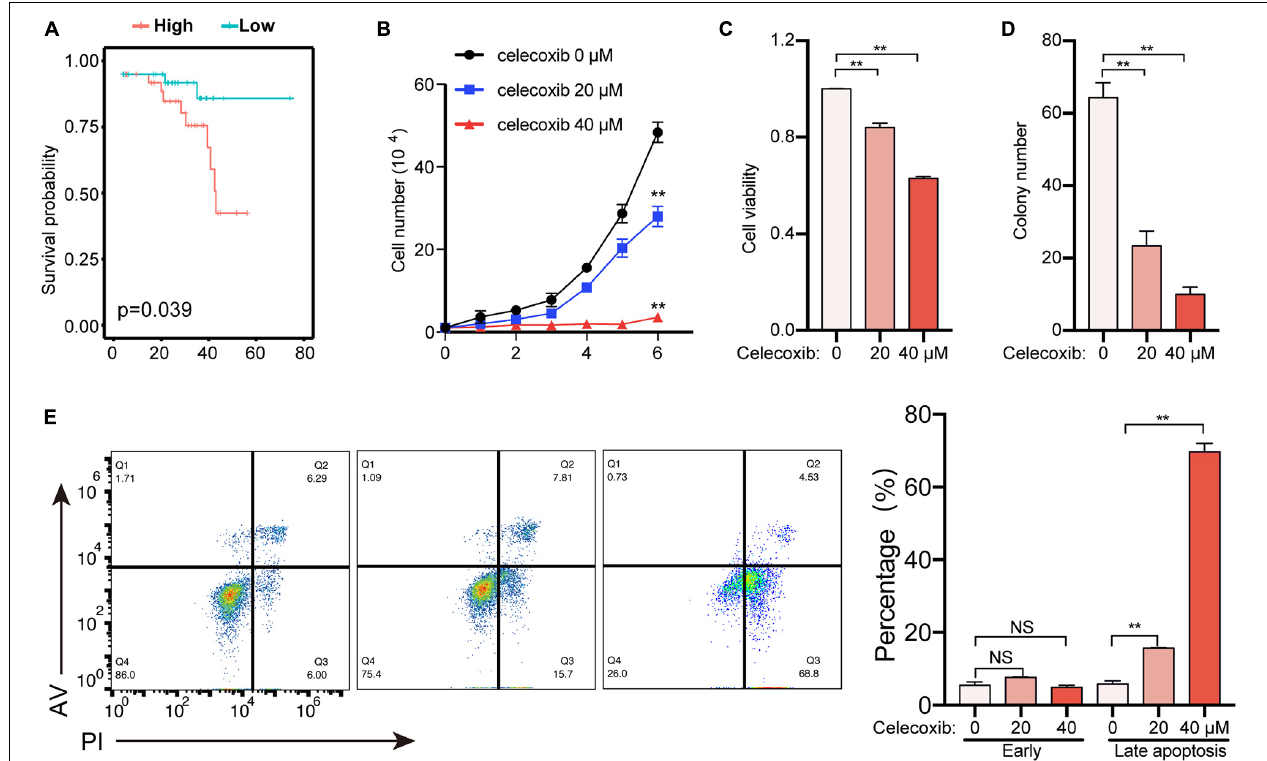
FIGURE 4 | PTGS2 is a potential therapeutic target to treat uveal melanoma. (A) Survival analysis of PTGS2 expression in UVM. The PTGS2 expression above the median is defined as high and below the median is defined as low. (B) OCM1 cells growth curve was detected for 6 days after celecoxib treatment. (C) OCM1 cells viability was detected using CCK8 after celecoxib treatment for 1 day. (D) OCM1 cells clone formation was detected. The number of cell clones was more than 2 mm in diameter. (E) OCM1 cells apoptosis was detected after celecoxib treatment for 3 days. ** P <